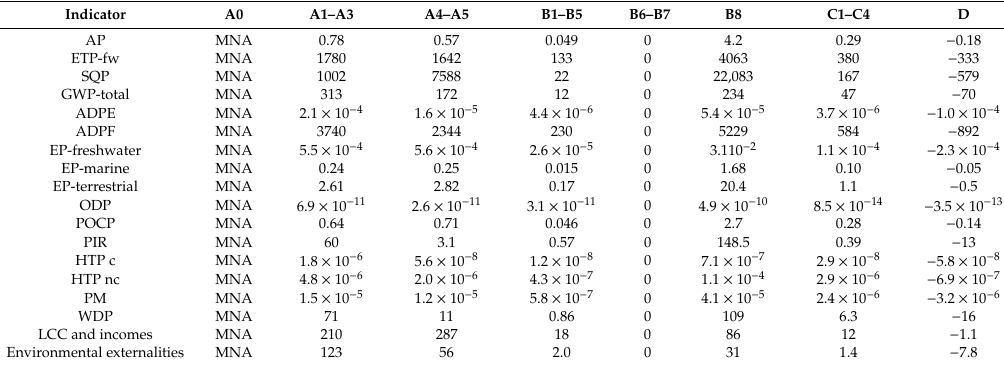
Table 4. Results for the concrete slab frame bridge (CSF) bridge design concept per indicator in units of measurement per life-cycle stage for the functional unit. Modules not assessed are abbreviated as “MNA”.